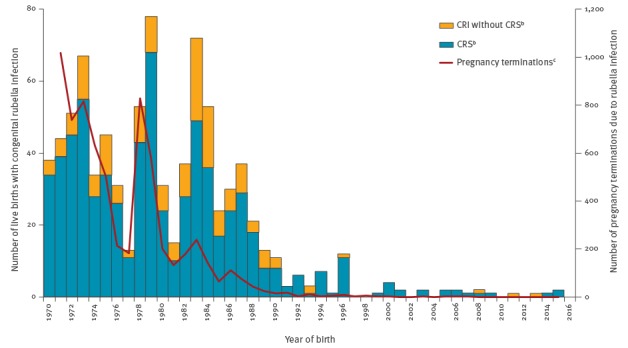
Infants with congenital rubella infection and those diagnosed with congenital rubella syndromea (live births) and pregnancy terminations due to rubella infection during pregnancy, United Kingdomb, 1970−2016